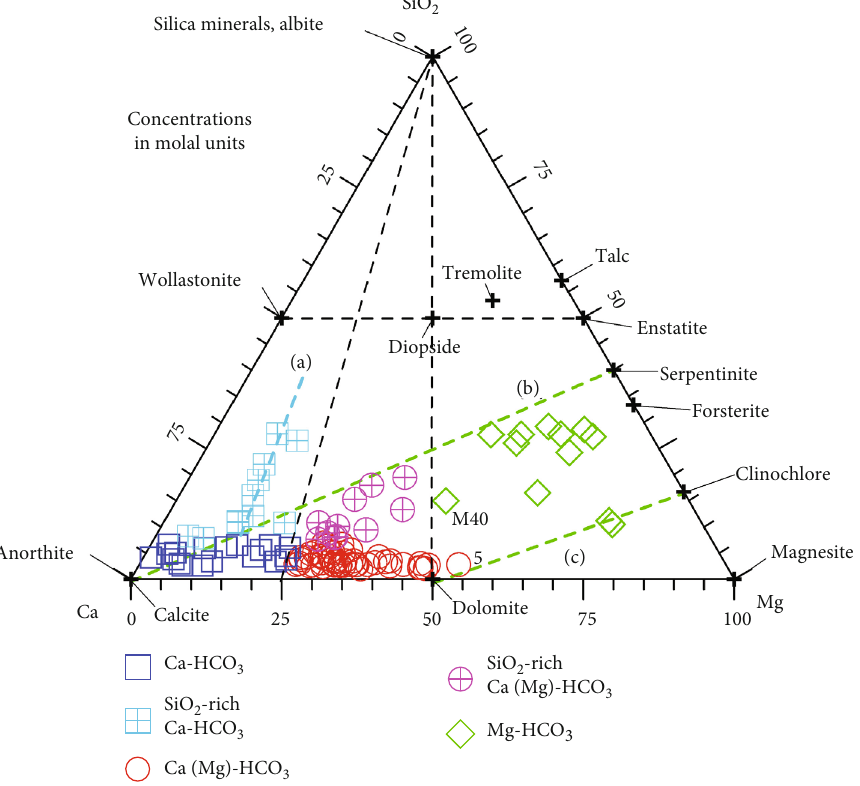
Figure 3: Triangular diagram of Ca-Mg-SiO